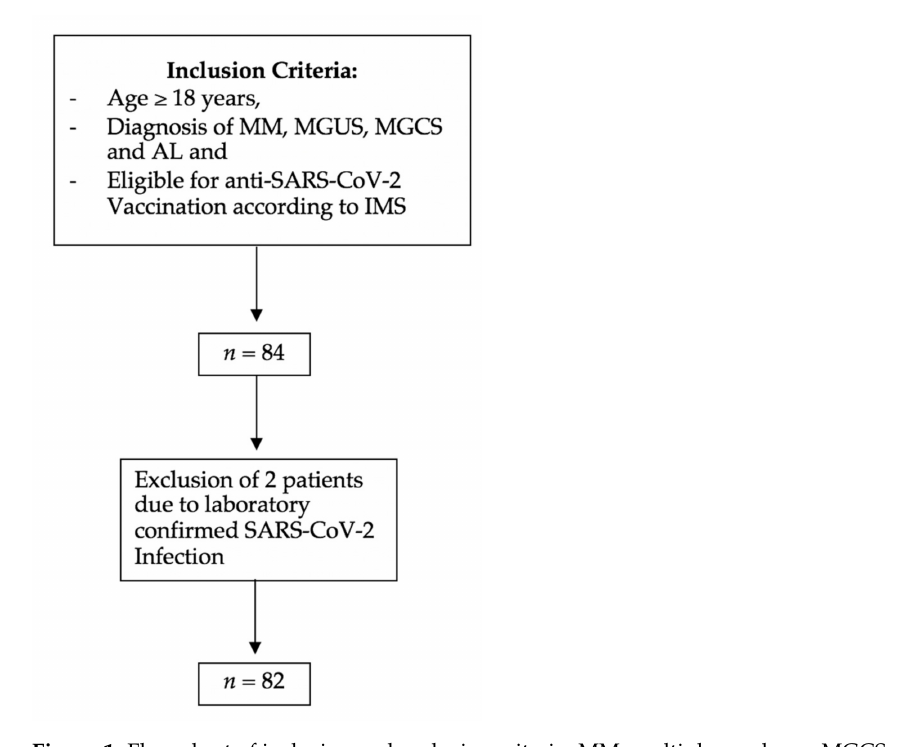
Figure 1. Flow chart of inclusion and exclusion criteria. MM, multiple myeloma; MGCS, monoclonal gammopathy of clinical significance; MGUS, monoclonal gammopathy of unknown significance; AL, systemic light-chain